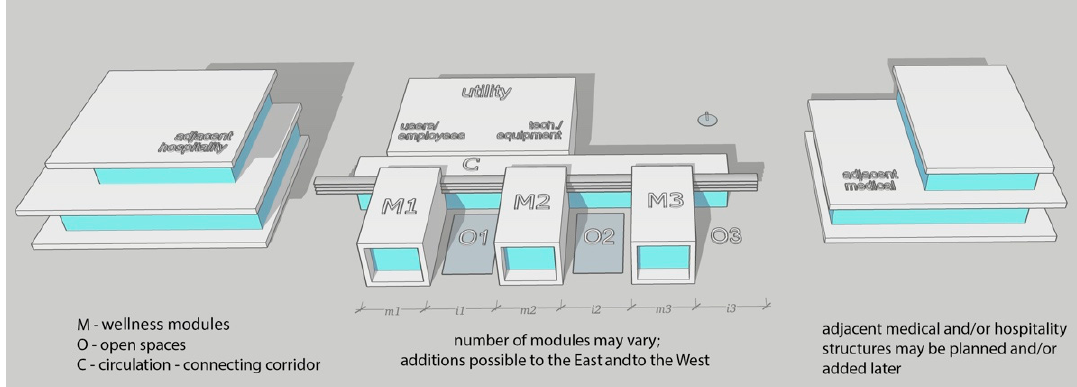
Figure 7. Model for modular wellness facilities with optional hospitality and medical facilities.